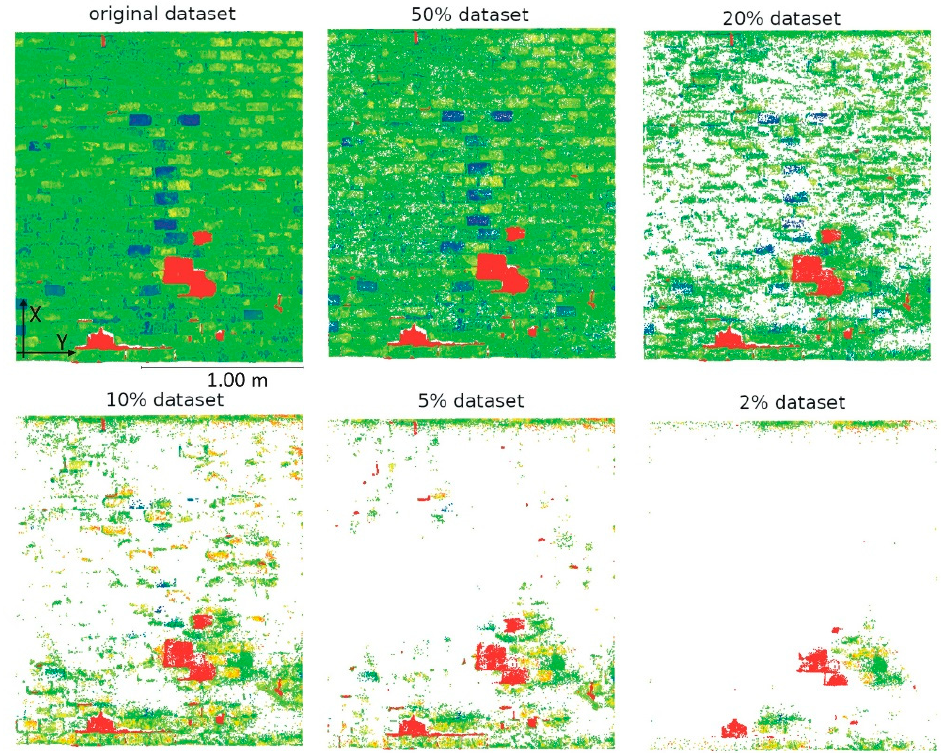
Figure 7. Damage mapping results in a brick wall using the OptD method.